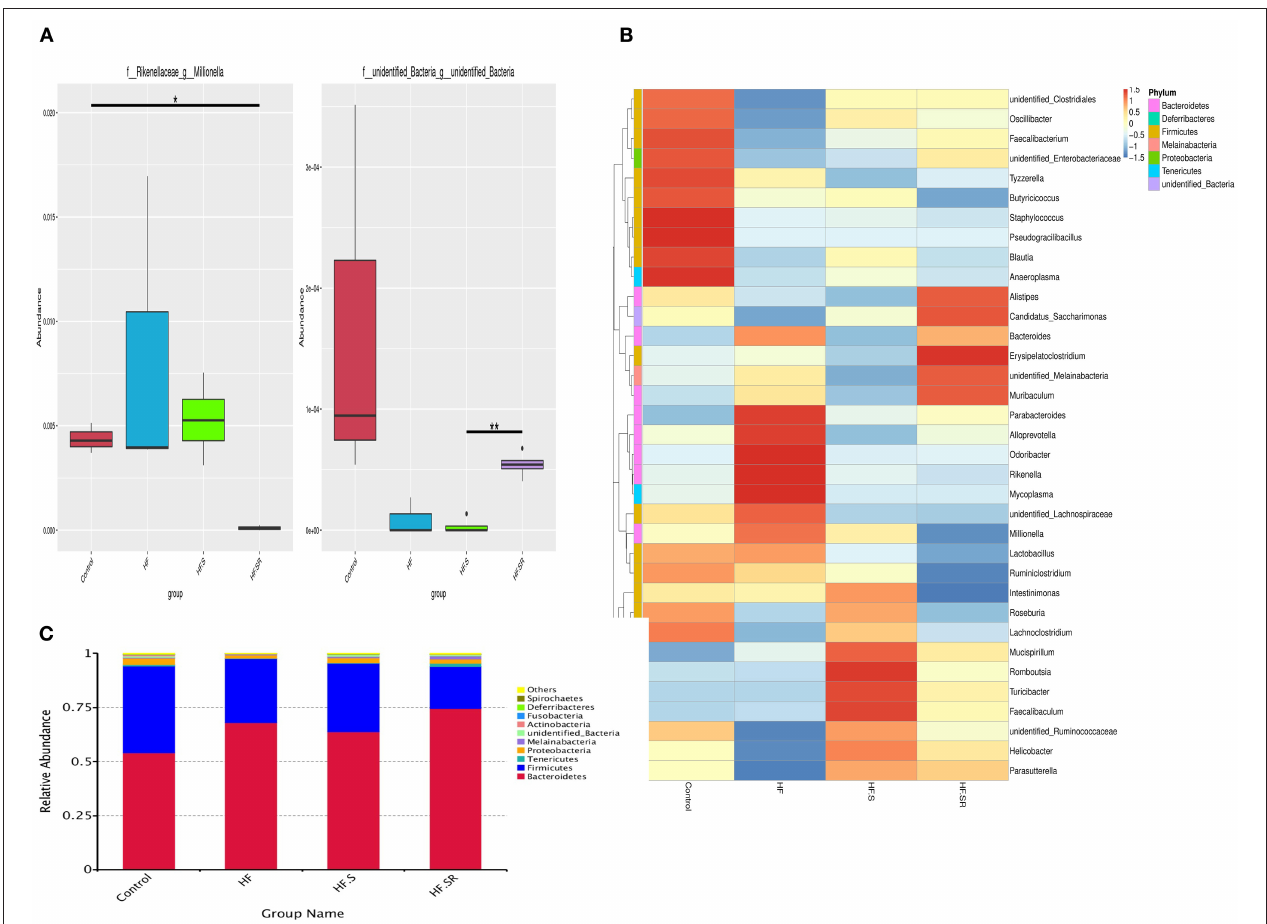
FIGURE 8 | Distribution of bacterial abundance. MetaStat analysis showing the bacterial abundance at the genus level among the control ( n = 4), HF ( n = 5), HF + S ( n = 8) and HF + SR ( n = 8) mice (A) . Top 35 most frequent bacterial genera in the four different groups (B) . Relative abundance of the major phyla among the gut microbiota in the four groups. Bacteroidetes and Firmicutes were the two most abundant bacteria (C) . * P < 0.05 vs. controls. ** P < 0.05 vs. HF.S